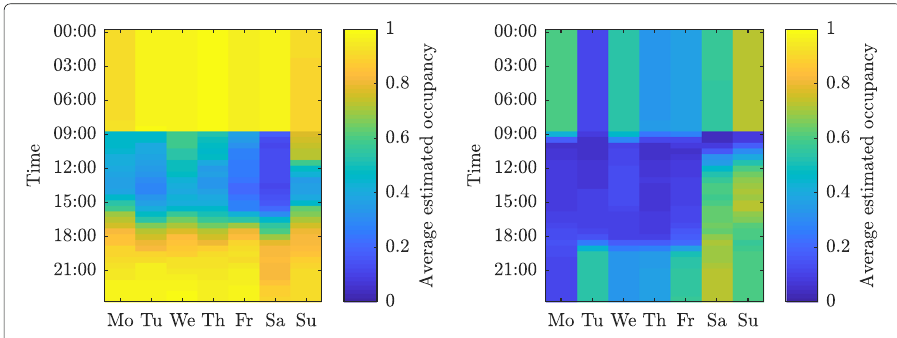
Fig. 2 Average weekly schedules for two different households (Becker and Kleiminger 2018). The higher the value (as displayed by the colour) in a time slot, the likelier the home is occupied during that time